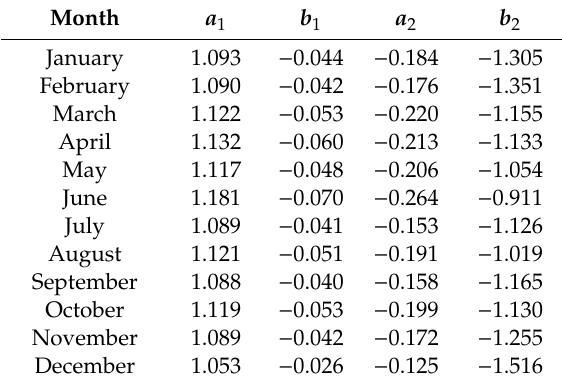
Table 1. The optimal coe ffi cient of the HFM for each